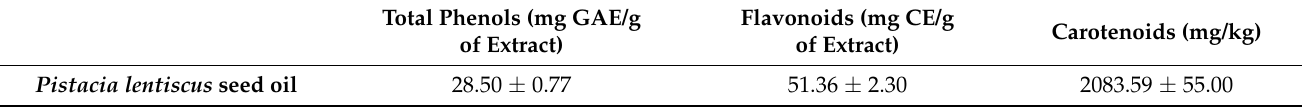
Table 1. Total phenols, flavonoids, and carotenoids contents of Pistacia lentiscus seed oil (PLSO).